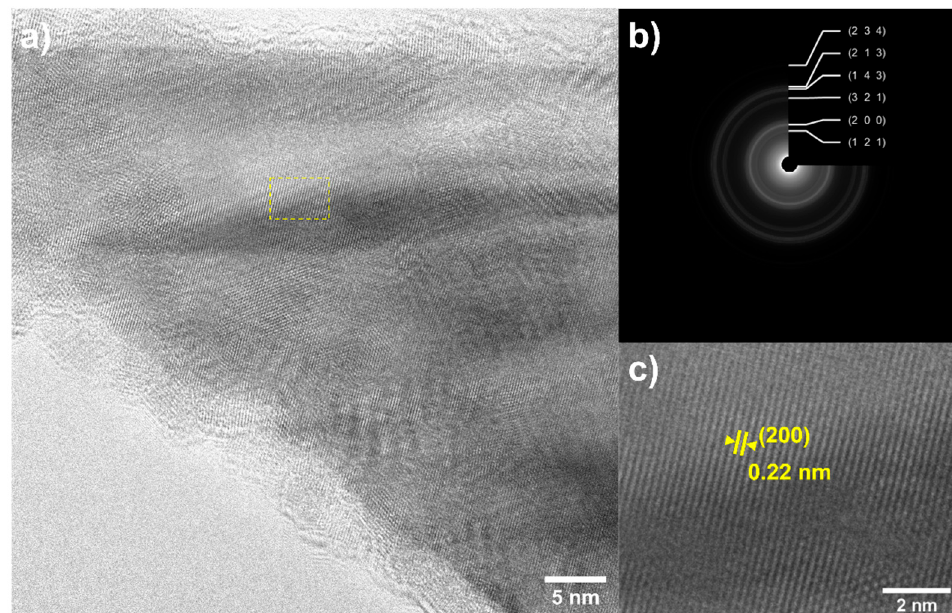
Figure 9. ( a ) TEM image of SnS scratched off from the films deposited on molybdenium substrate at T = 350 °C for 15 min, ( b ) ring diffraction pattern (upper inset), and ( c ) HRTEM image showing the (200) planes of the orthorhombic SnS (lower inset) .